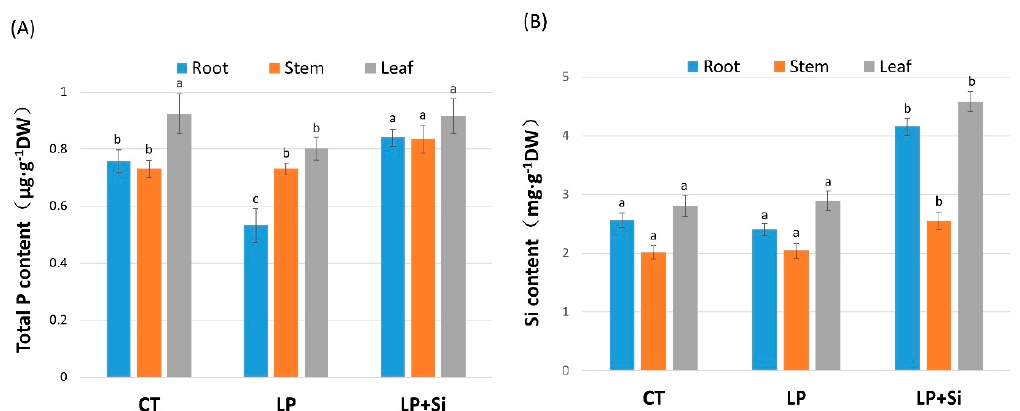
Figure 5. Accumulation of phosphorus and silicon in different tissues of tomato plants as influenced by low phosphorus (LP) and silicon (Si) supply: ( A ) Total P content and ( B ) Si content in tomato roots, stems, and leaves. Data are shown as means ± standard deviation (SD) of three replicates. Bars with the same color but different letters indicate statistically significant differences at p ≤ 0.05. Table 4. Effects of exogenous silicon on the concentrations of minerals in tomato under deficit phosphorus supply.